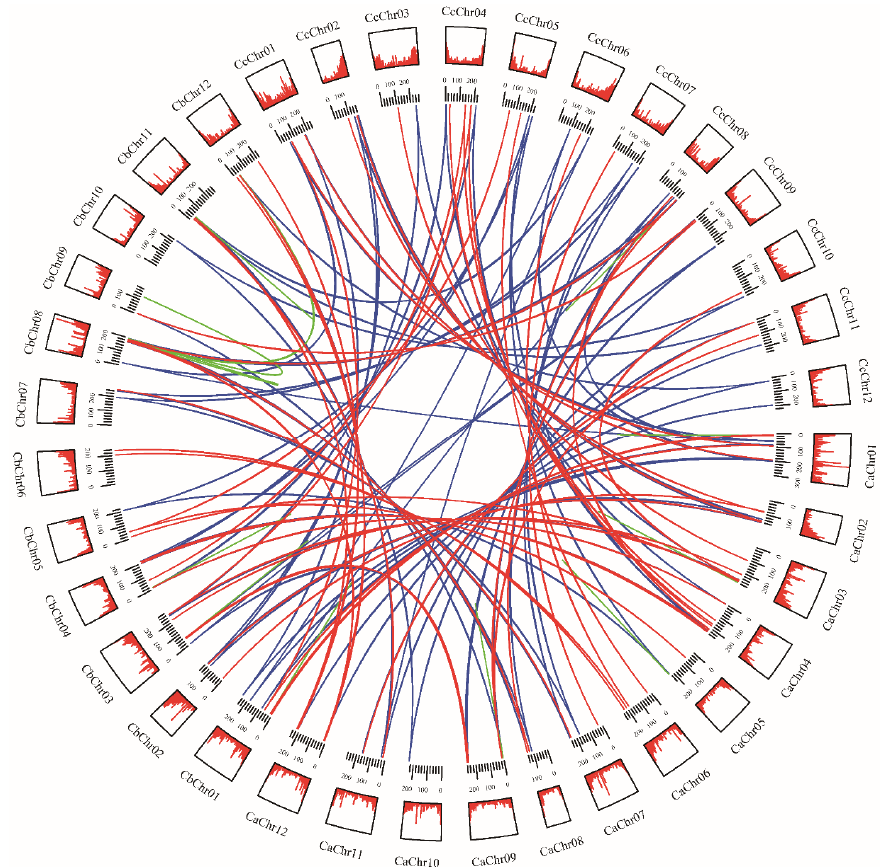
Figure 3. Homologous MADS - box gene pairs in Capsicum annuum (Ca), C . baccatum (Cb), and C . chinense (Cc). Tracks from outside to inside are chromosomes numbers, gene density of the chromosome, and homologous gene pairs among the three Capsicum species. Blue lines connect homologous gene pairs that exist in three Capsicum species; red lines connect homologous gene pairs in two species; green lines connect paralogous genes.